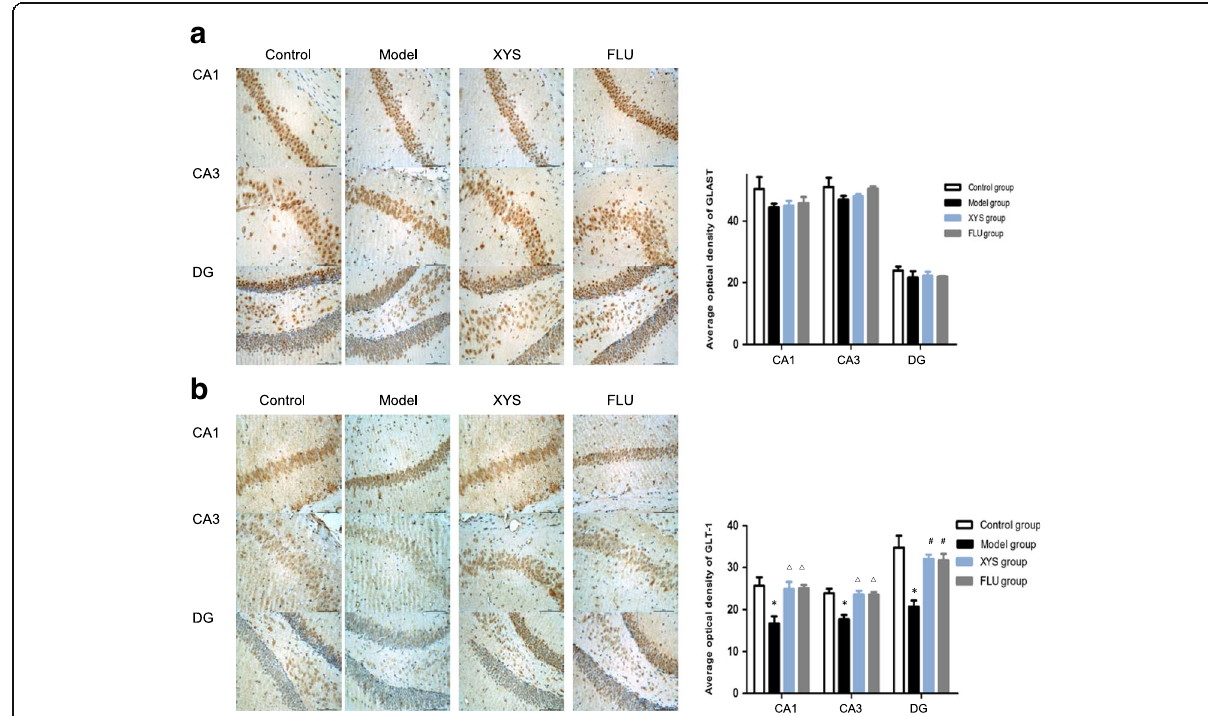
Fig. 6 Alterations of GLAST and GLT-1 immunoreactivities in the hippocampi of mice by CUMS as well as XYS and FLU treatment. a , b The AOD of GLAST and GLT-1 in the hippocampal subregions CA1,CA3 and DG were determined by immunohistochemical staining. Abbreviations:CA1 and CA3: hippocampal subregions of ammons horn (cornu ammonis), DG:dentate gyrus. Data were expressed as mean ± S.E.M, n = 5 per group. ∗ P < 0.05 vs. control; △ p < 0.05, # p < 0.01 vs.